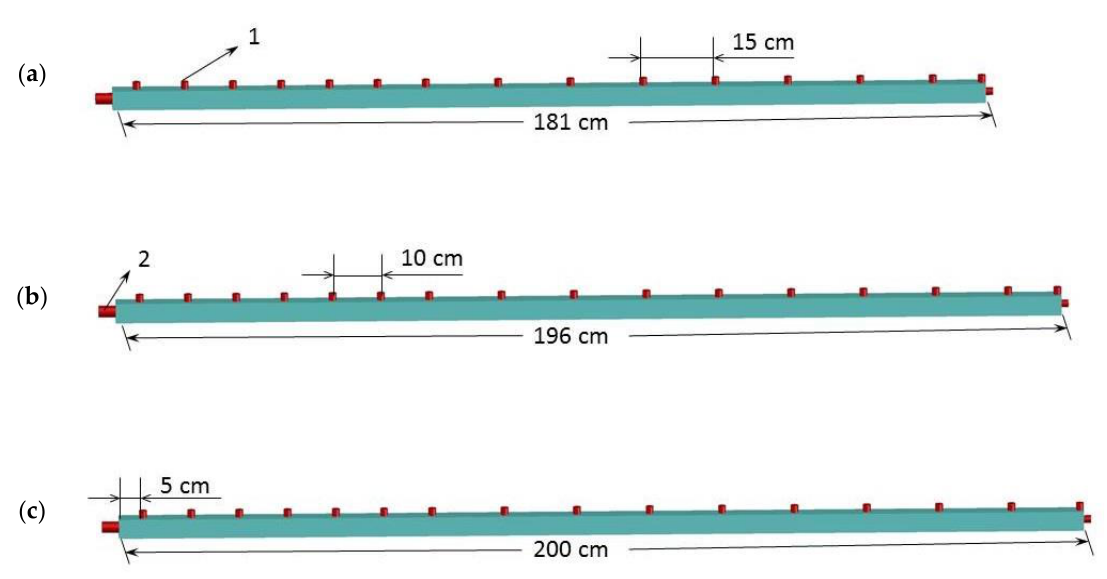
Figure 4. Sensor arrangement for ( a ) red sandstone, ( b ) marble, and ( c ) granite: 1—sensors for elastic wave collection; 2—transducer for elastic wave excitation with various frequencies. Table 2. Signal collection sensor layout scheme.